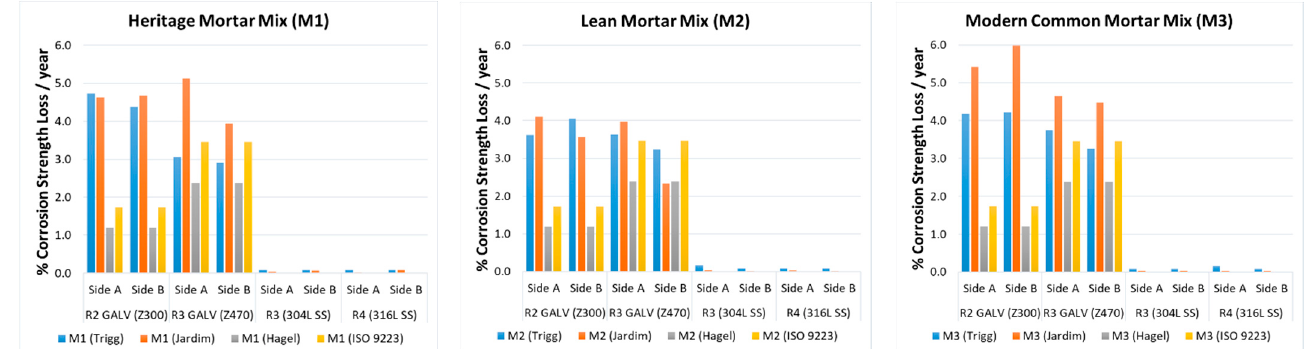
Figure 2. Percentage corrosion strength loss per year that is proportional to the mass loss data for the various wall tie materials that were tested, grouped per in the type of mortar in which they were embedded. Data from this field trial, which are represented via Trigg (blue), are compared to other data sets (Jardim, Hagel and ISO9223). Side A represents samples directly facing the sea, while side B represents the samples facing the opposite direction.